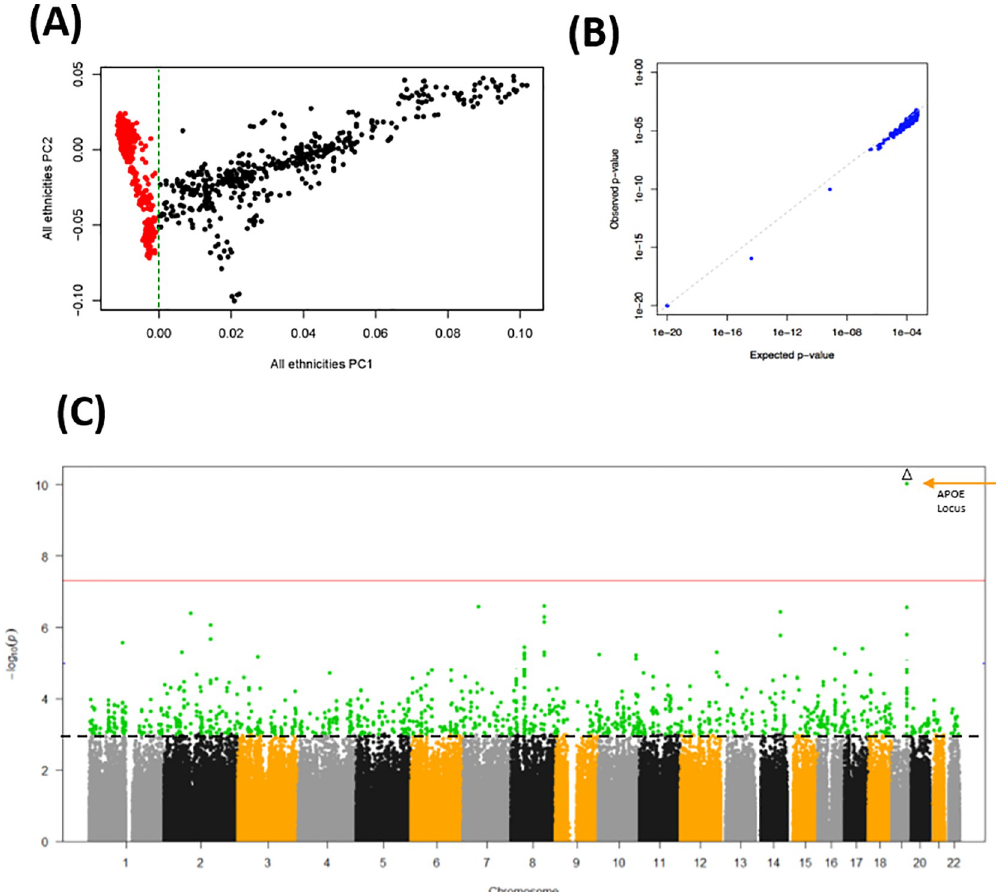
Fig 2. Validation of the data processing procedure. (A) First two principal components representing ethnic clusters. Red dots represent patients of European origin. (B) Validation of p-values compared to those from a reference study. (C) Manhattan plot of the obtained p-values in -Log10 scale. APOE locus is indicated. The red line shows genome-wide significance. The dotted black line marks a reference at 10 − 3 . Because of the large -Log10 p-values of the APOE locus, the overall scale has been reduced for